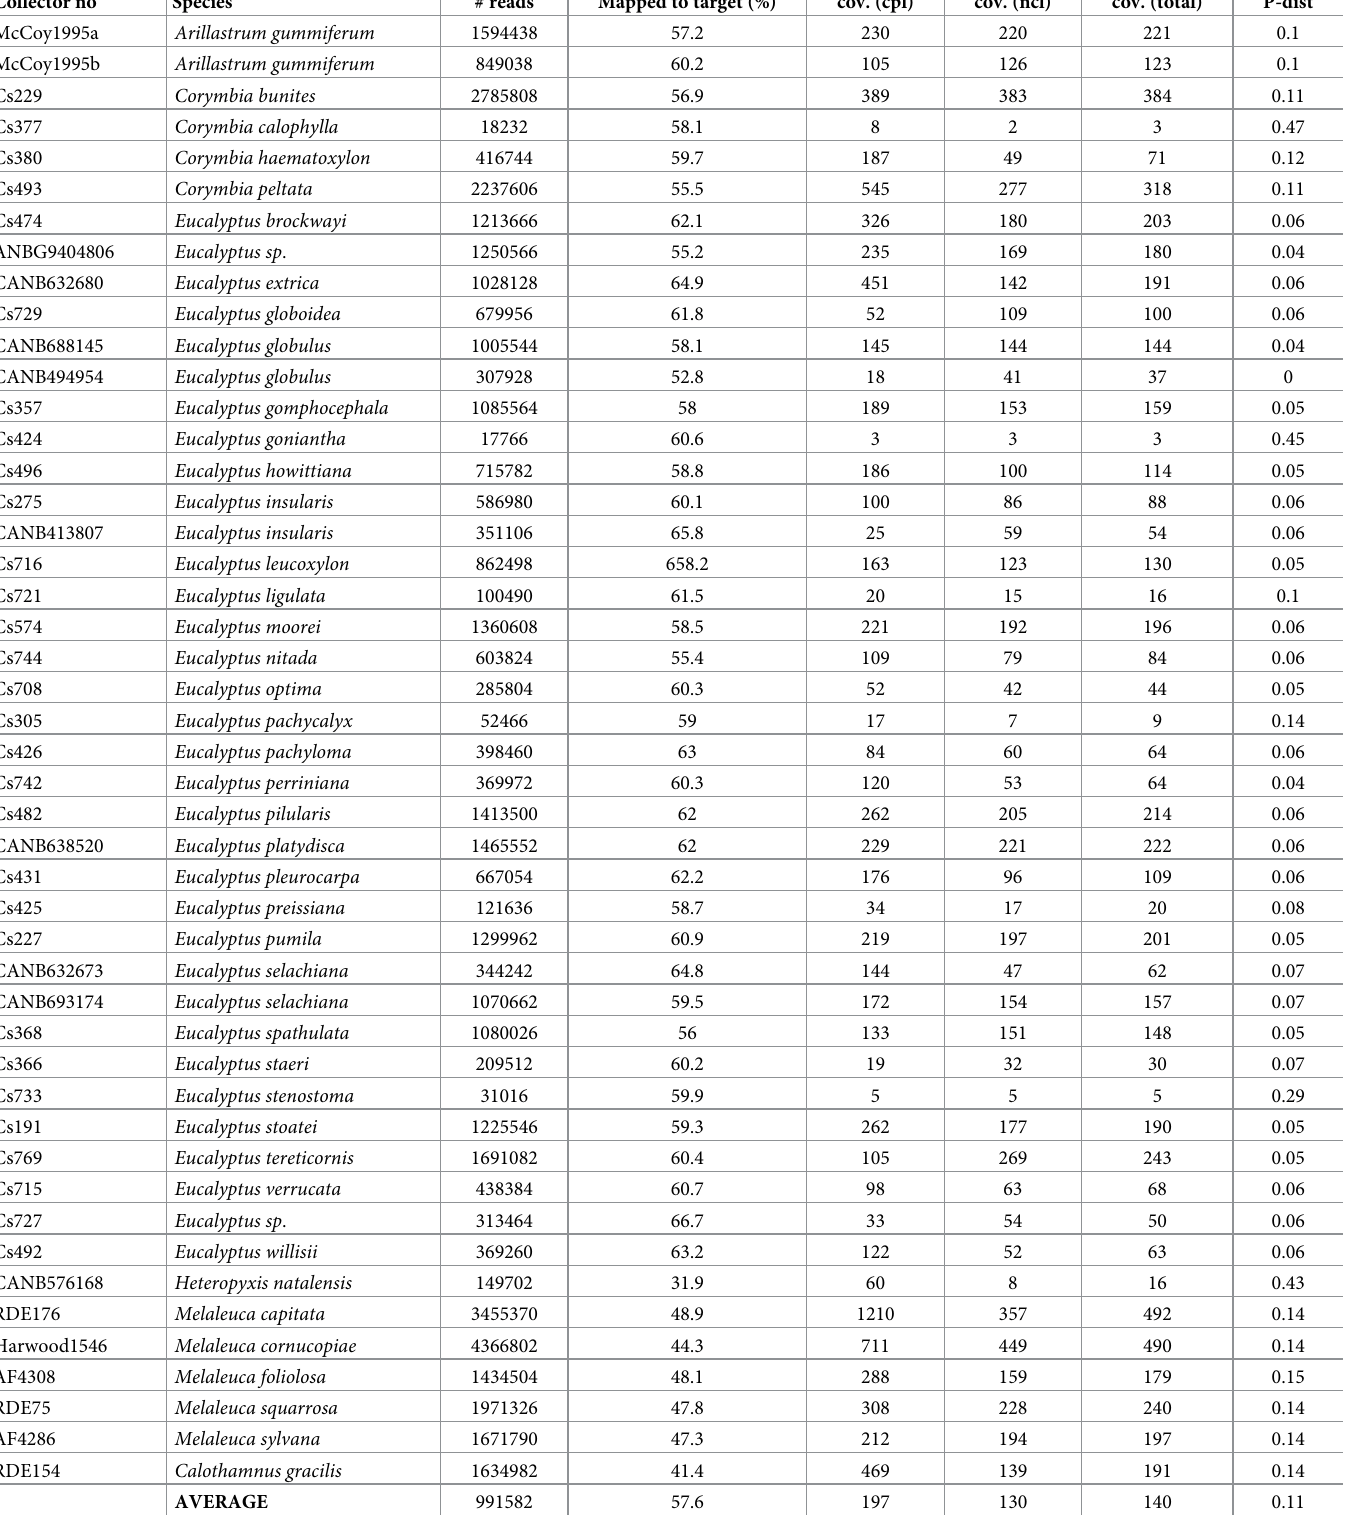
Table 1. Number of reads, percentage of reads mapped back to the Eucalyputus grandis targets and the average coverage of 47 samples (chloroplast, nuclear and total). P-distance (p-dist) of each species compared to Eucalyputus globulus subsp. pseudoglobulus . Collector